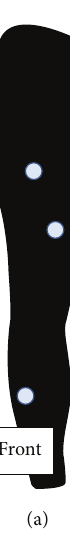
Figure 2: Position of the EMG electrodes on the front of the right leg (a) and back of the right leg (b). Muscle activity was measured at the rectus femoris (RF), vastus medialis (VM), tibialis anterior (TA), biceps femoris (BF), lateral gastrocnemius (GA), and soleus (SO) of the right leg.